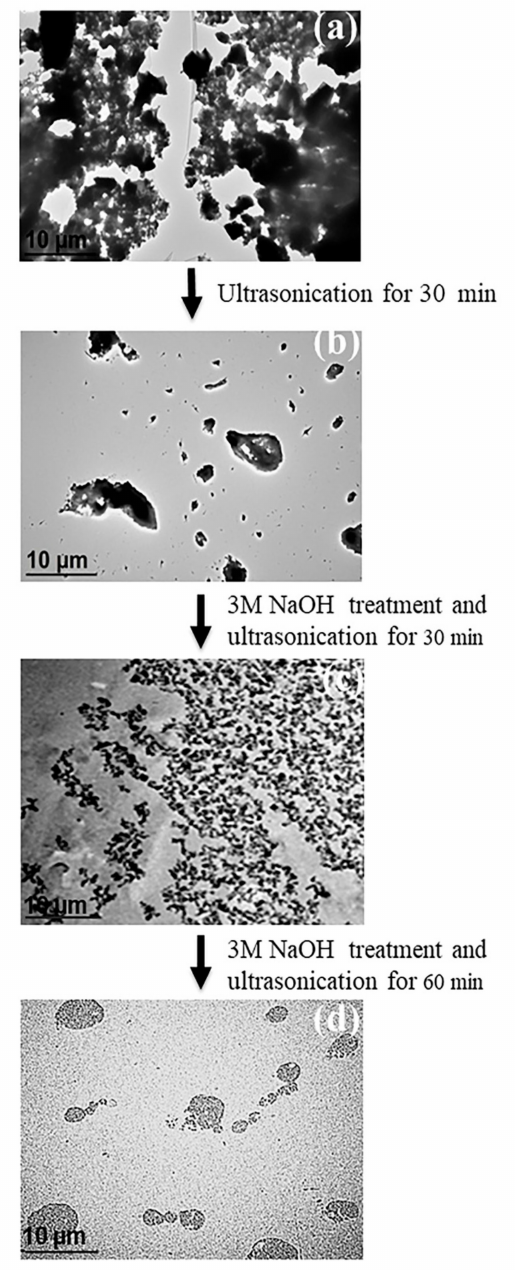
Figure 8. TEM micrographs of OPA particles: ( a ) original OPA, ( b ) untreated OPA after ultra- sonication for 30 min, ( c ) 3M NaOH-treated OPA followed by 30 min ultrasonication and ( d ) 3M NaOH-treated OPA followed by 60 min